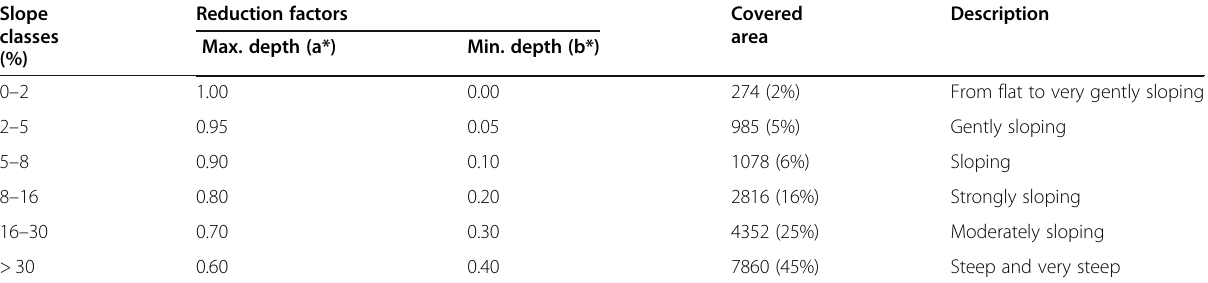
Table 3 Maximum and minimum soil depth reduction factor area coverage and description related to slope classes Slope